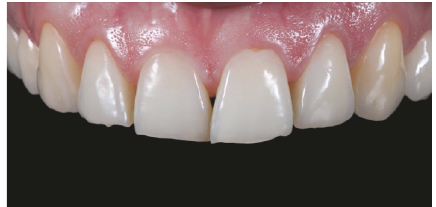
Figure 1: Intraoral image, showing disharmony in position and size, dental attrition, and erosion.